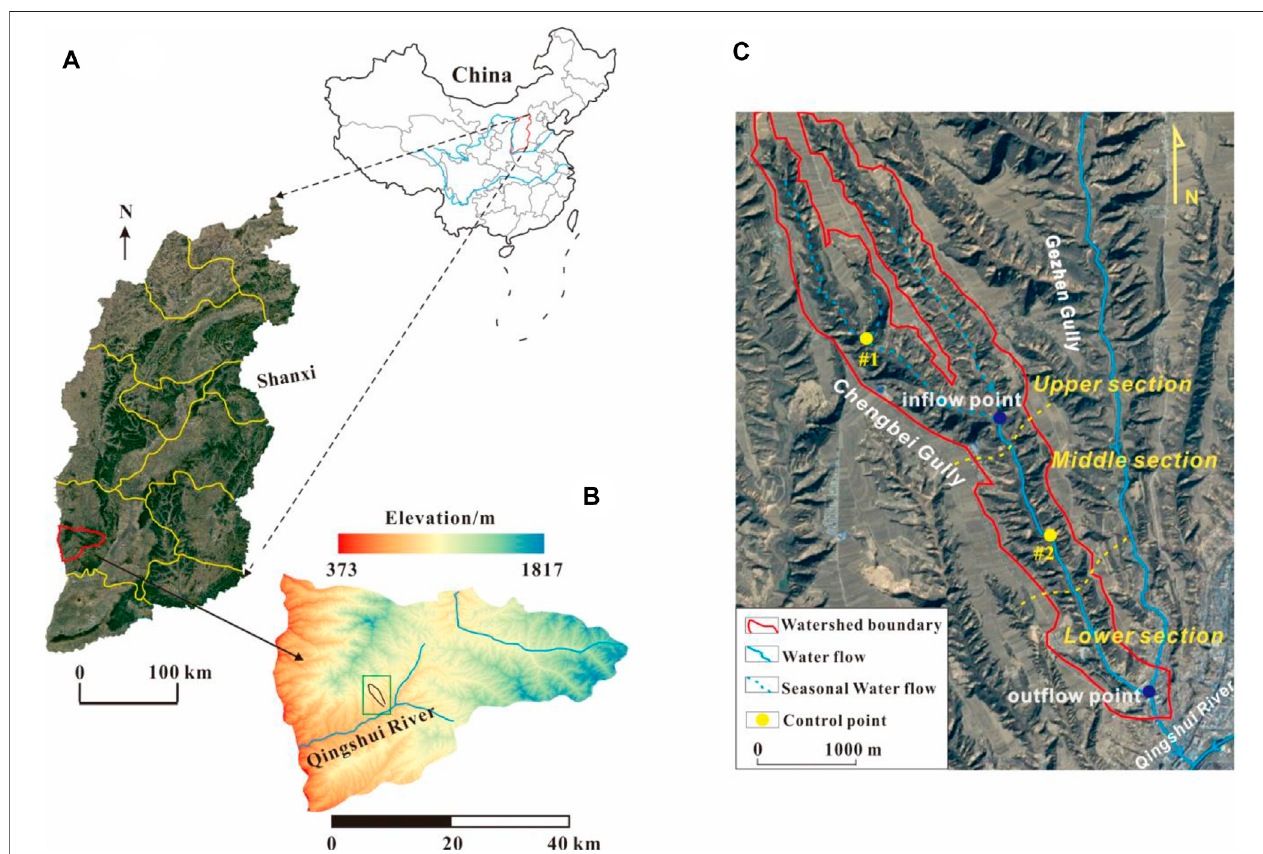
FIGURE 1 | Location of the Chengbei Gully: (A) location of Shanxi Province, (B) location of the Chengbei Gully in Ji County, and (C) topography map of the Chengbei Gully obtained from remote sensing images.